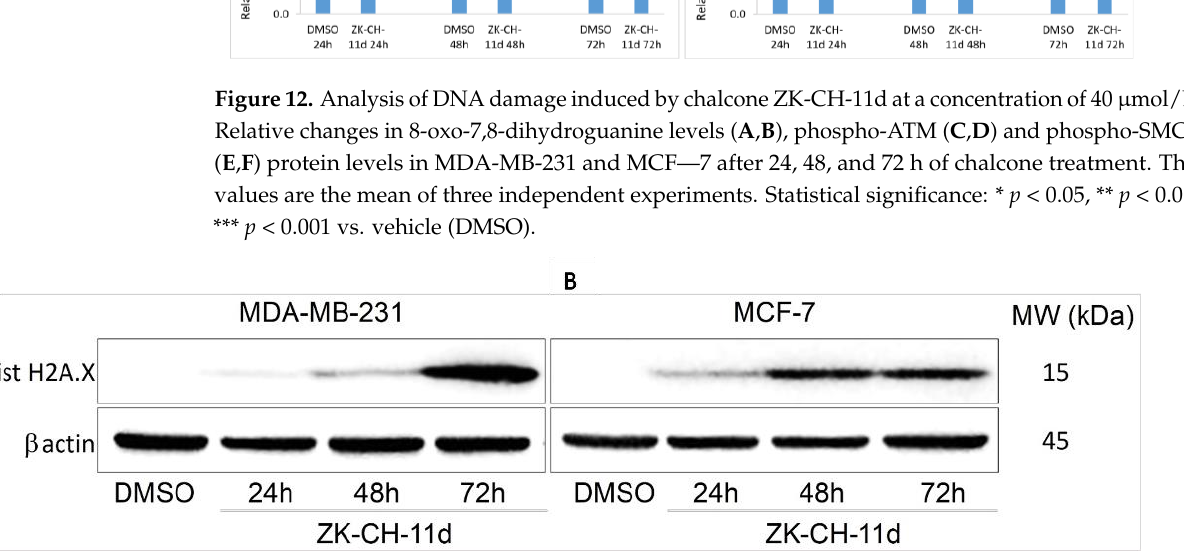
Figure 13. Western blot analysis of H2A.X phosphorylation after 24, 48, and 72 h of ZK-CH-11d treatment in MDA-MB-231 ( A ) and MCF-7 ( B ) cells.